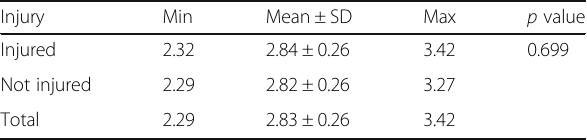
Table 5 Descriptive statistics for foundry workers ’ risk perception score by injury occurrence ( N = 109) in Tehran, Iran,